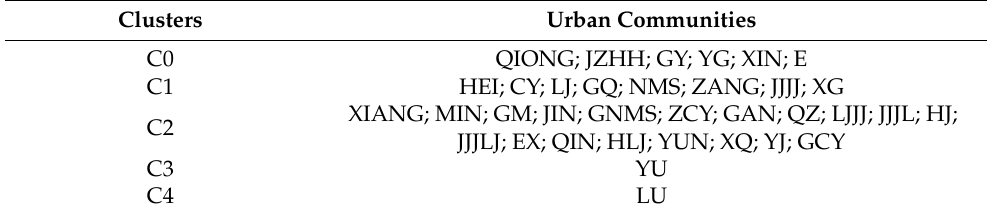
Table 4. Clustering results of urban communities.